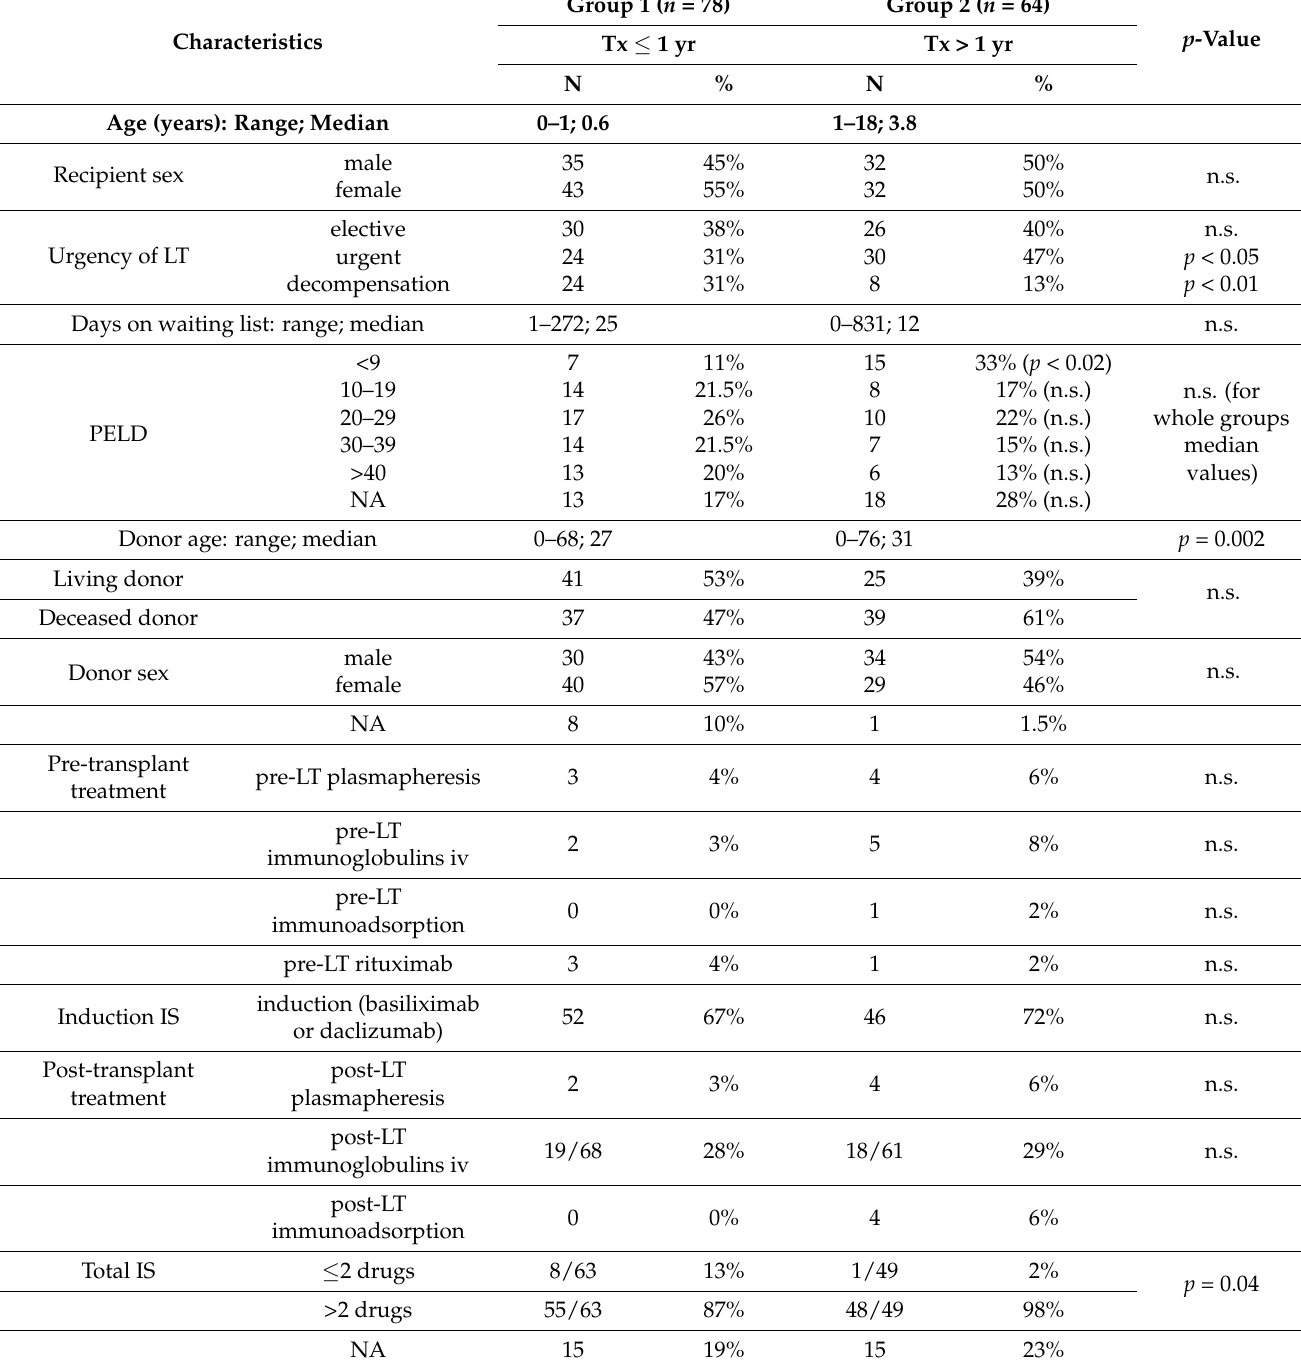
Abbreviations Table 1: Tx—transplantation, yr—year, NA—status unknown, pre-LT—before liver transplantation, post-LT—after liver transplantation, iv—intravenous, n.s.—not